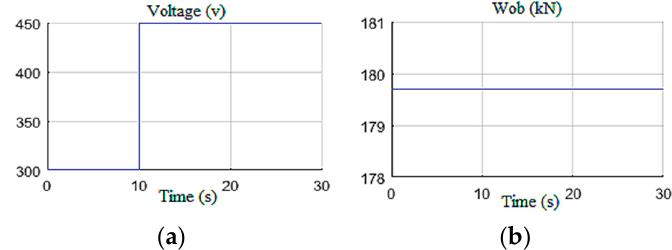
Figure 10. Test inputs for Scenario 1: ( a ) the voltage; ( b ) the Wob.